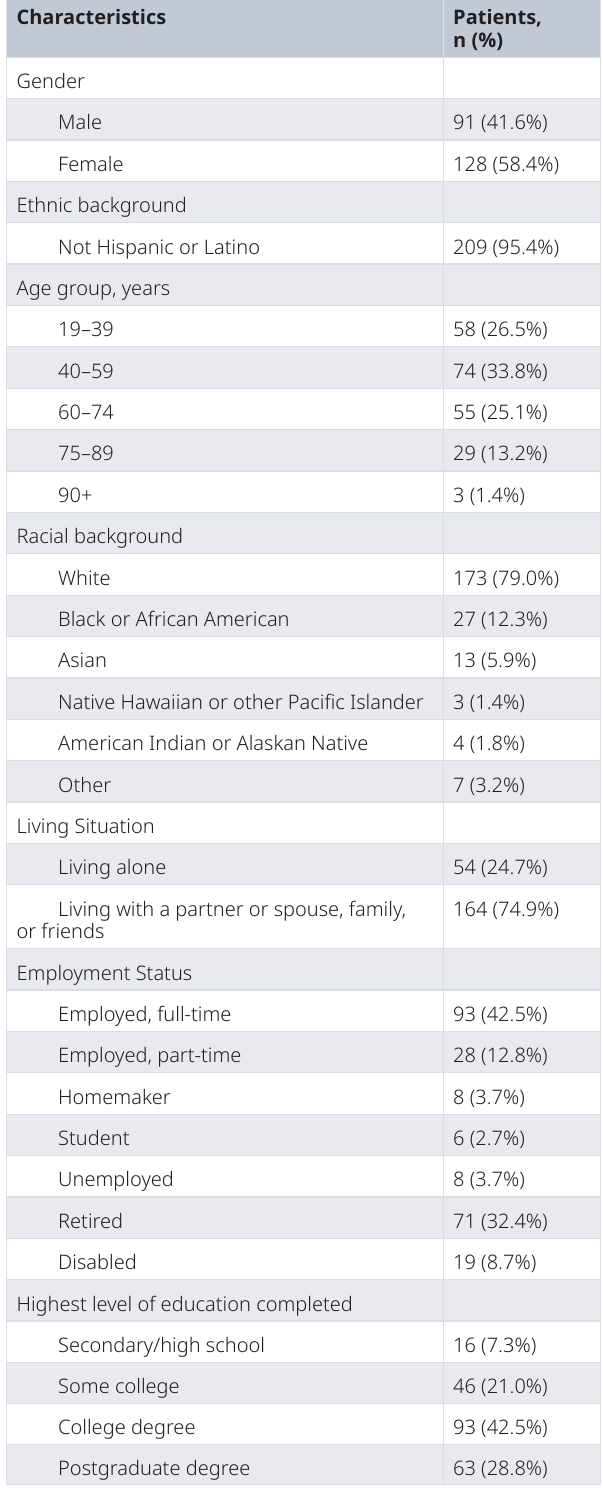
Table 4. Demographic and clinical characteristics of aortic stenosis patients who completed the preference elicitation survey